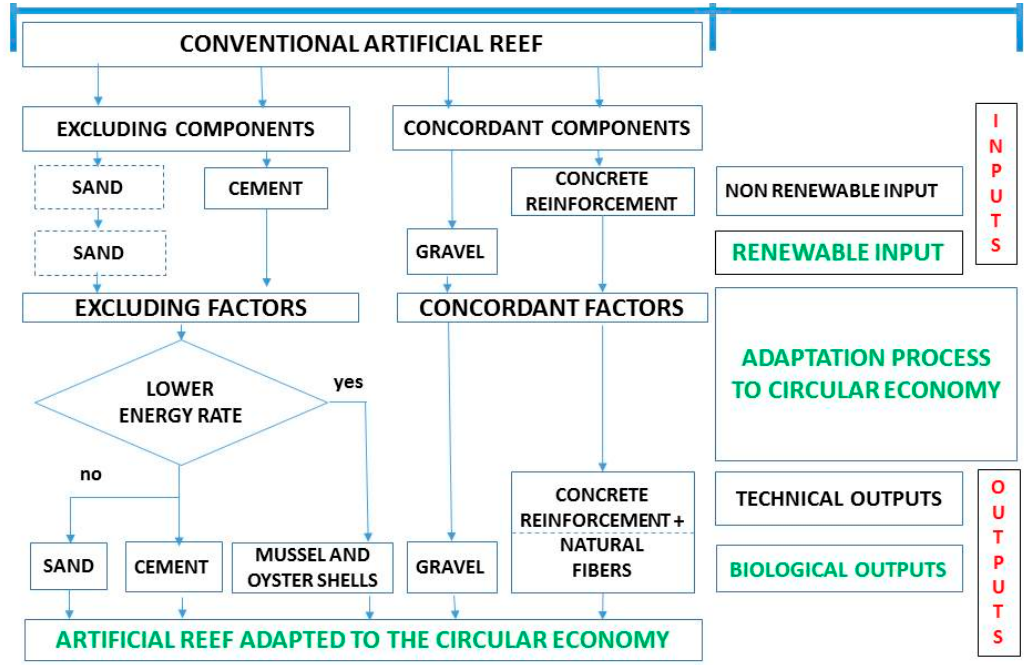
Figure 3. Decision tree that allows the transformation of a conventional artificial reef into an artificial reef adapted to the circular economy.